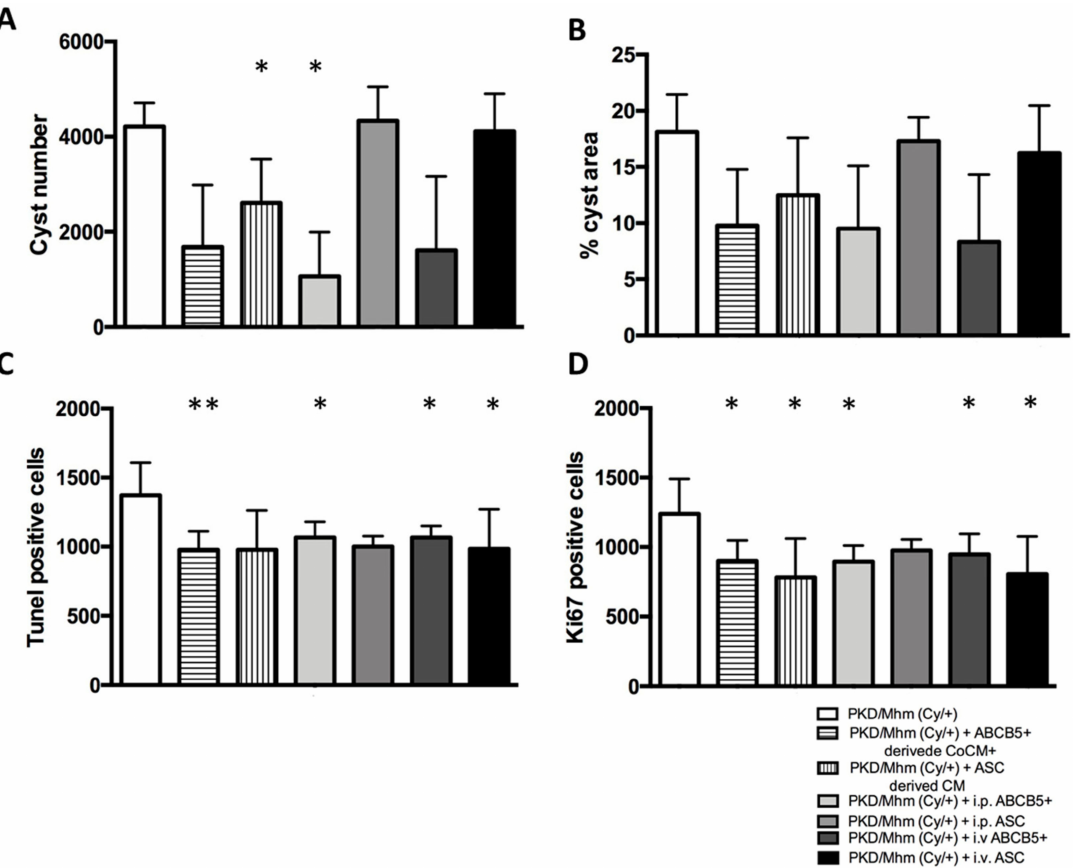
Figure 4. Histological changes in PKD/Mhm (Cy/+) rats after treatments (n = 6 in each group). Changes in cyst number ( A ), percentage (%) of cyst area ( B ), Tunel-positive cells ( C ) and Ki67-positive cells ( D ). Histograms show means ± Std.Dev. * p < 0.05, ** p <